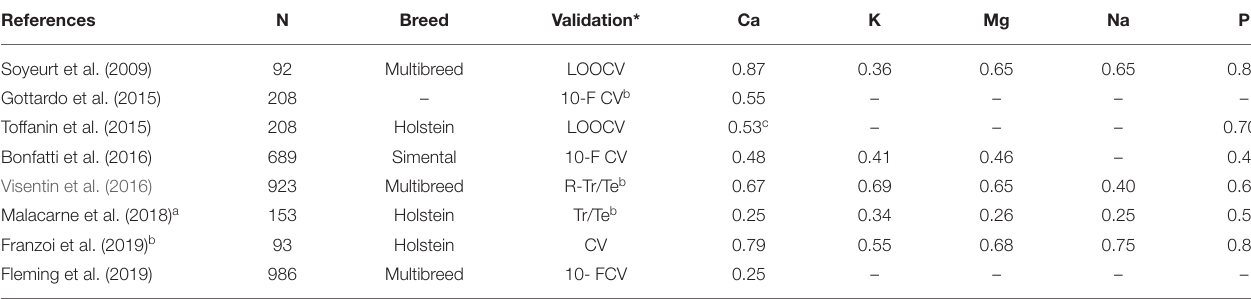
TABLE 5 | Number of samples (N) and coefficient of determination in the validation set for mineral contents using partial least square